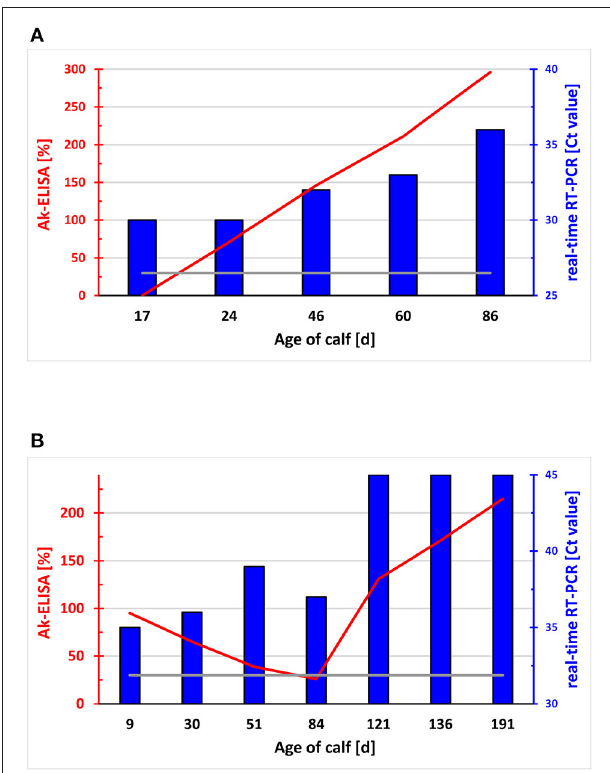
FIGURE 3 | Course of the level of pestivirus antibodies and viral RNA in the blood of newborn calves. Relative optical density (OD) in the ELISA for pestivirus antibody in sera of two calves taken between day 17 and 86 (A) and day 9 and 191 (B) of age expressed as a percentage to the OD of a standard serum (y-axes to the left in red). Relative OD values > 30% (grey line) are defined as positive. The presence of viral RNA by real-time RT-PCR, and the Ct values are indicated (y-axes to the right in blue). The calf in (A) did not receive pestivirus antibody-containing colostrum, whereas the calf in (B) ingested maternal antibodies to BDV. The virus detected by RT-PCR could be identified as BVDV-1b [ A ; ( 79)] and BDswiss [ B ; (145)],